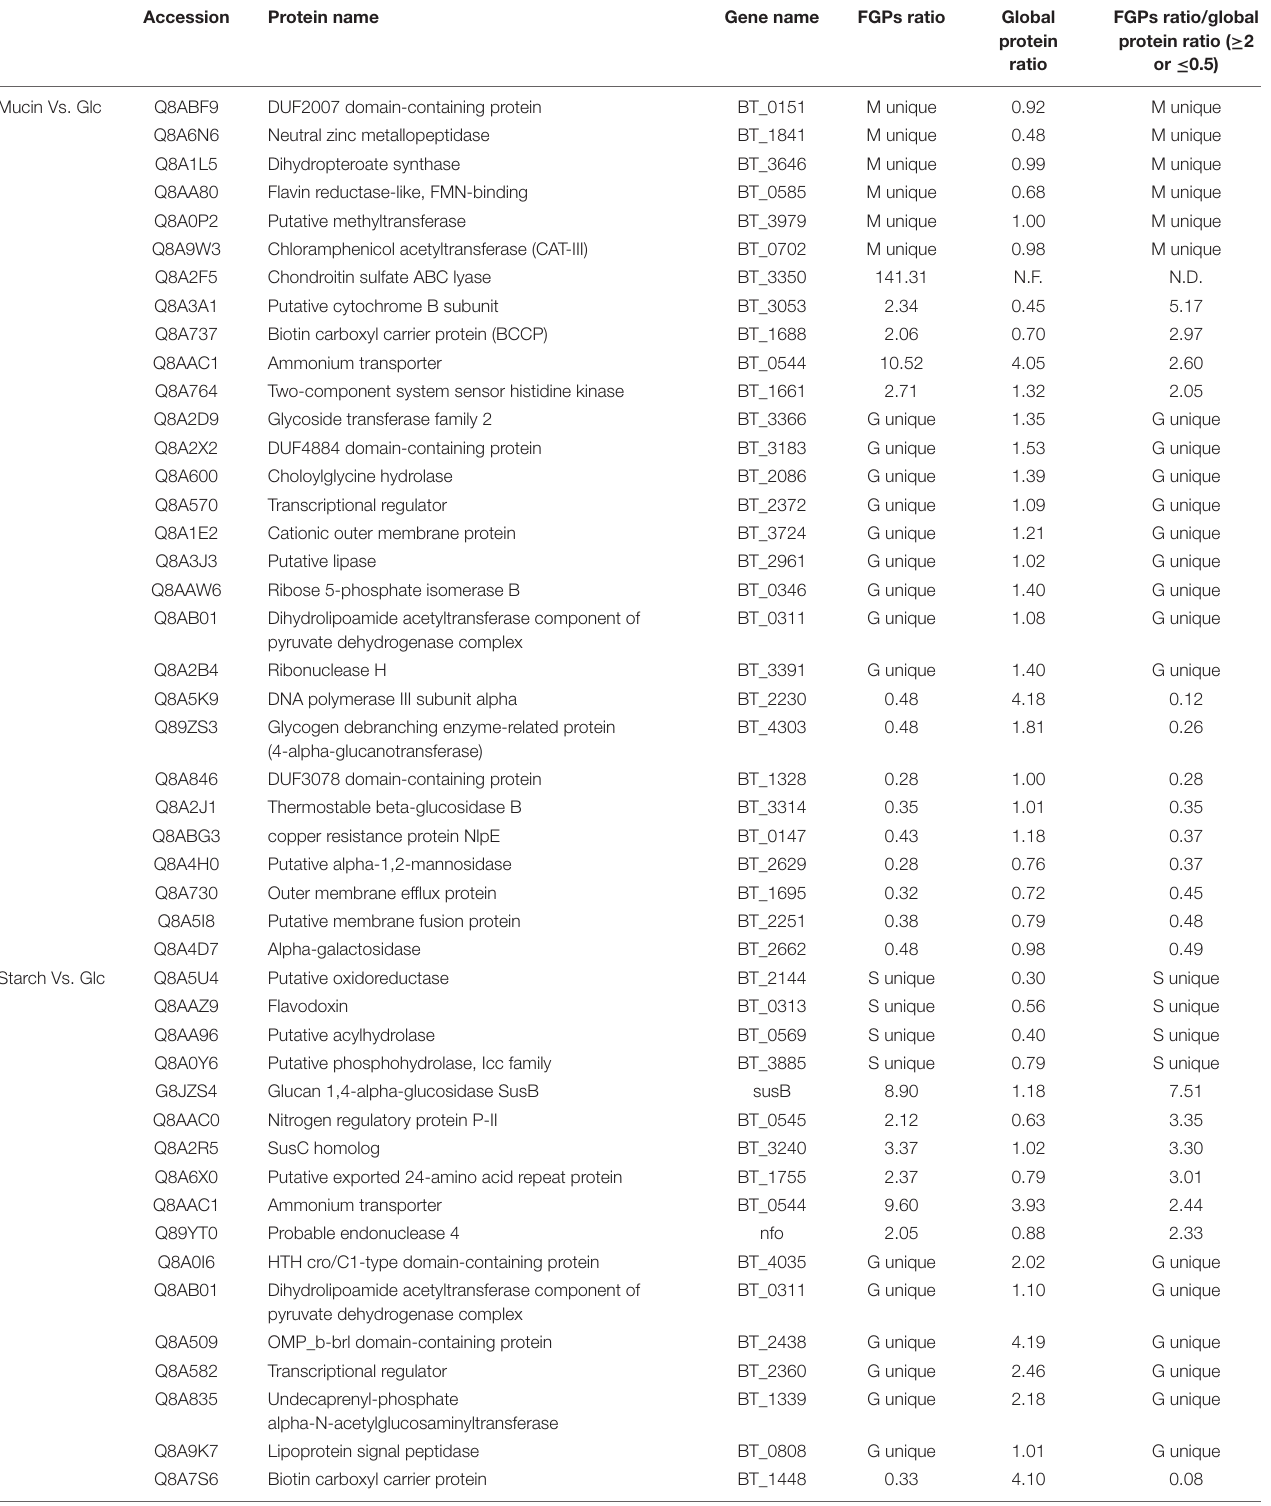
TABLE 1 | Key FGPs with significantly altered fucosylation level under different polysaccharide nutritional conditions. Accession Protein name Gene name FGPs ratio Global